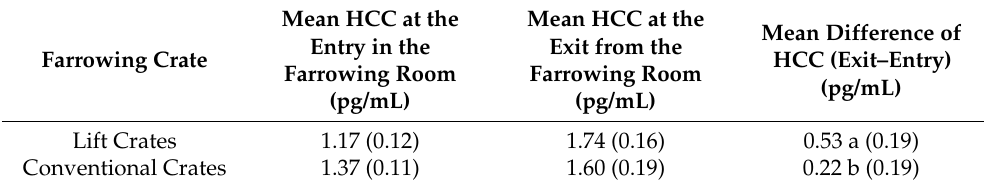
Table 5. Mean hair cortisol upon entry to and exit from (and SEM) the farrowing room, and its variation in time; (a, b) data in the same column differ for p < 0.05.